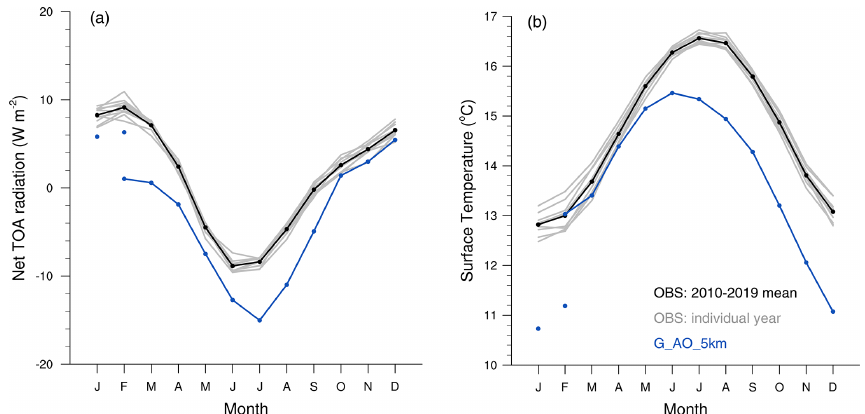
Figure 4. Seasonal cycle in (a) net TOA radiation and (b) surface temperature from observations and G_AO_5km. Observations in (a) are from CERES-EBAF (Clouds and the Earth’s Radiant Energy System–Energy Balanced and Filled, Loeb et al., 2018) version 4.1 with a grid spacing of 1 ◦ and in (b) from HadCRUT (Hadley Centre/Climatic Research Unit Temperature, Morice et al., 2021) version 5.0 with a grid spacing of 5 ◦ . For G_AO_5km, the solid marked line shows the months in 2020 and the two dots in 2021.